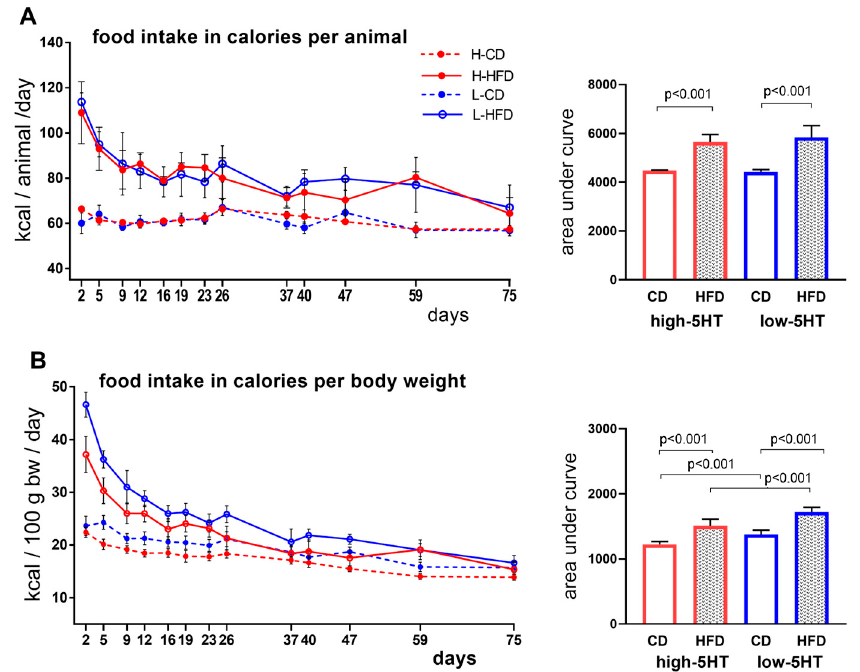
Figure 2. Daily food intake in animals from 5HT sublines over 11 weeks of feeding with control diet (CD) or high–fat diet (HFD), expressed in calories per animal ( A ) or calories per body weight ( B ). Corresponding area under curve (AUC) values are shown on the right. Data are presented as means ± SD; N = 9 per group; p -values obtained by LSD post-hoc test after one-way ANOVA. H-CD = animals from high-5HT subline on control diet; L-CD = animals from low-5HT subline on control diet; H-HFD = animals from high-5HT subline on high-fat diet; L-HFD = animals from low-5HT subline on high-fat diet.